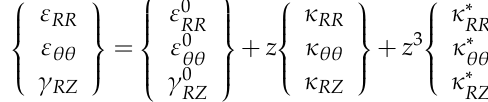
Figure 4. Through-the-thickness variation of mechanical properties ( θ = π /4, W CNT = 0.02, V F = 0.2 ).